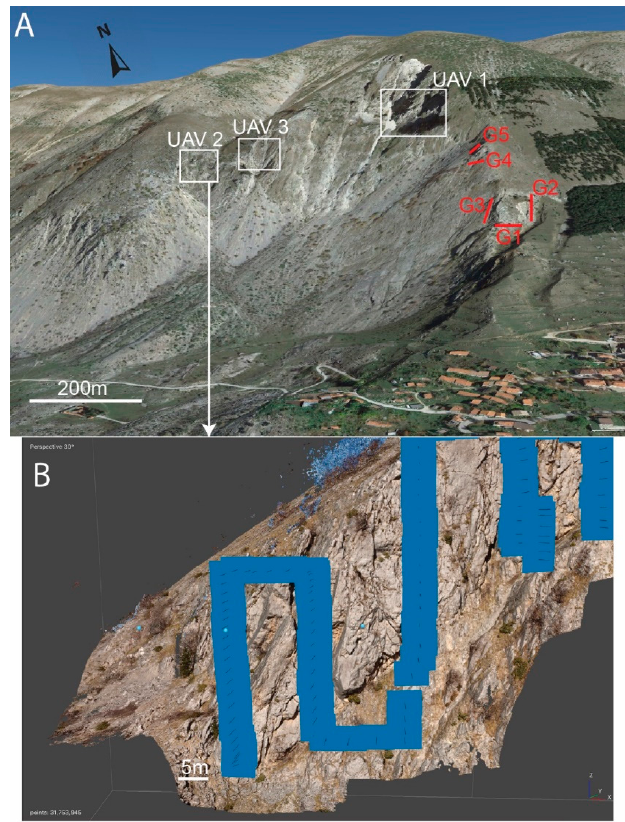
Figure 3. Conventional and UAV-based digital photogrammetry (DP) geomechanical surveys. ( A ) Conventional geomechanical scanlines (G1–G5, in red) and areas surveyed through UAV (UAV 1–3, in white). ( B ) Example of the flight plan for the area UAV 3.